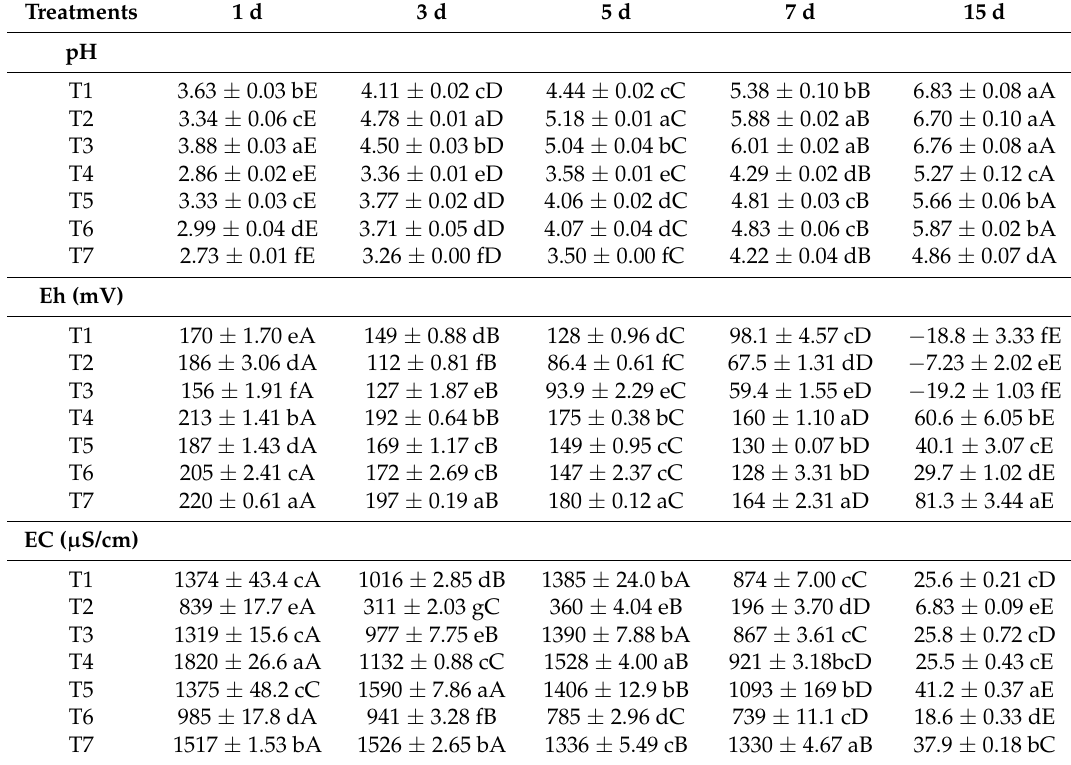
Table 3. Variation in pH, Eh, and EC in the extracting solutions during the period of the experiment.